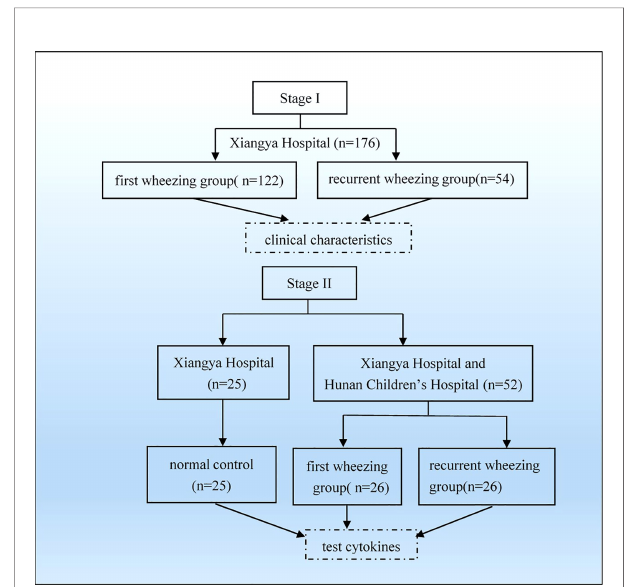
FIGURE 1 | Flowchart of grouping and analysis. Firstly, we collected 176 patients from Xiangya Hospital and grouped as fi rst wheezing (n = 122) and recurrent wheezing (n = 54) to analyze clinical characteristics. Then we collected 52 patients from Xiangya Hospital and Hunan Children ’ s Hospital and 25 normal control from Xiangya Hospital to test